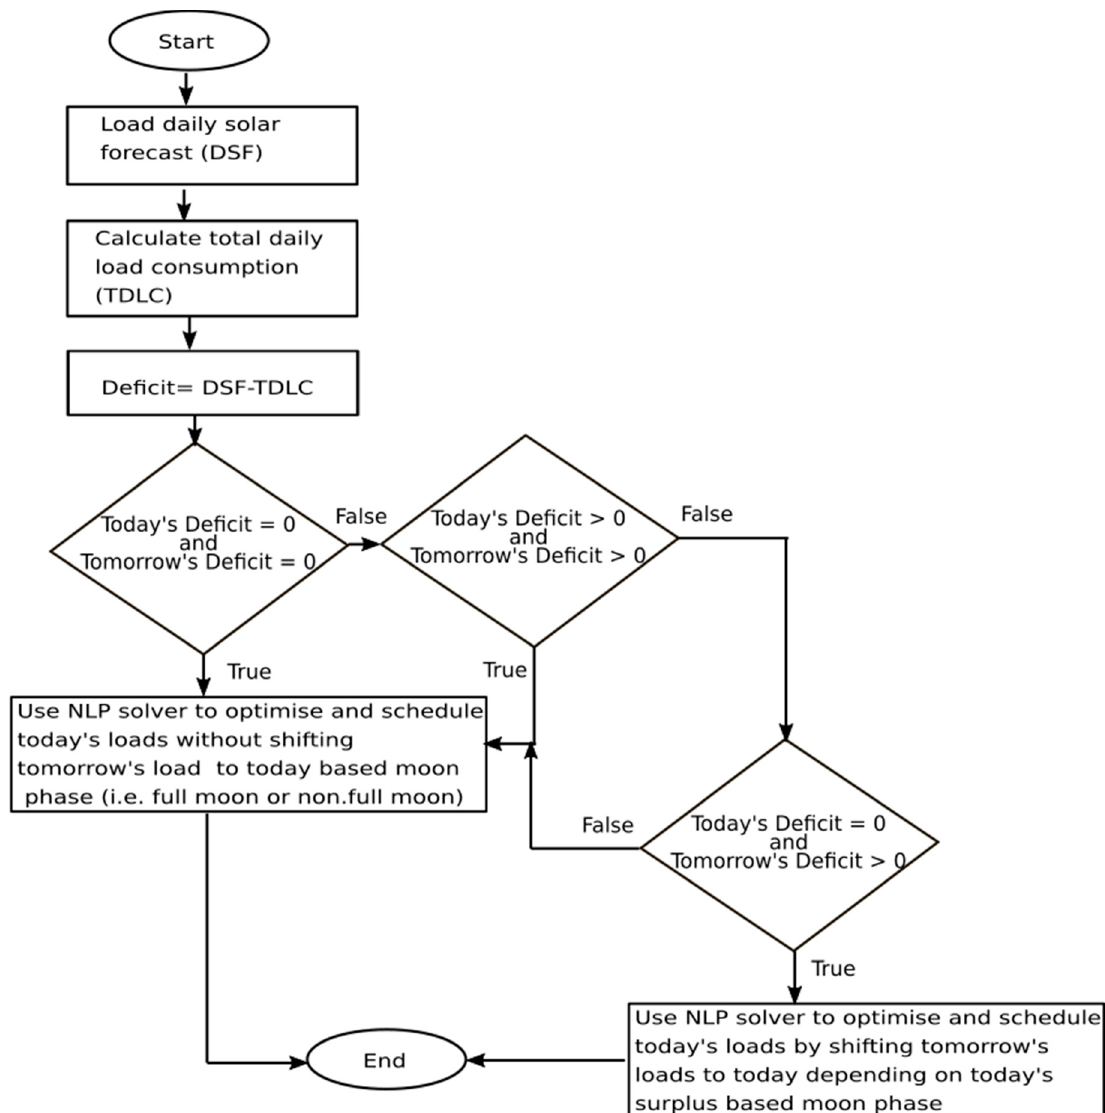
Figure 25. Flowchart of the NLP load optimization algorithm with load shifting concept.